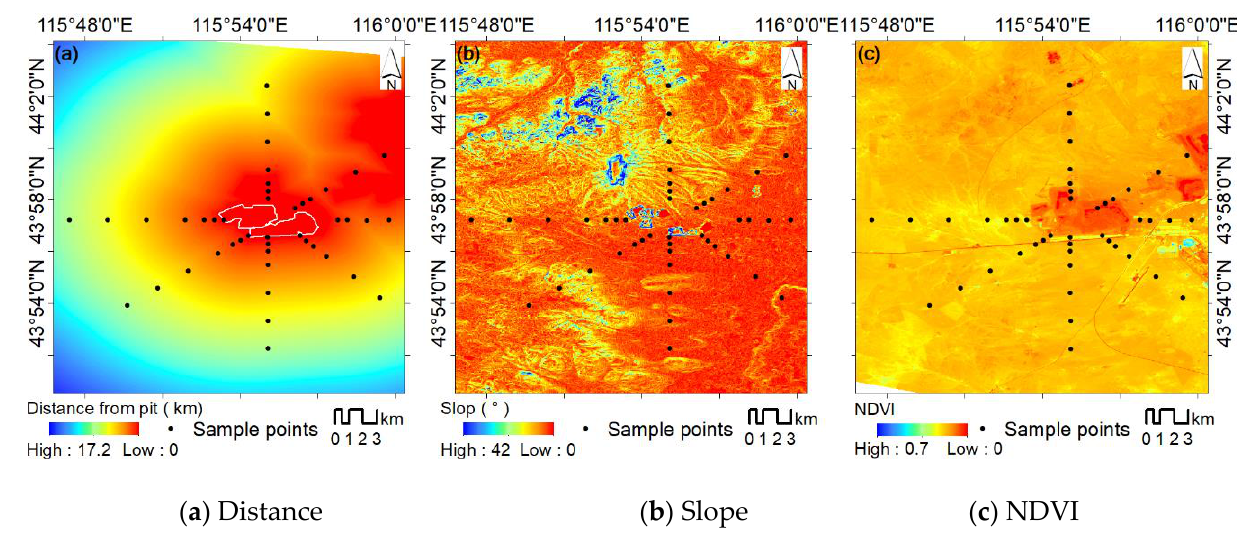
Figure 6. Distance ( a ), slope ( b ), and NDVI ( c ) from the mine in the study area. Table 4. Linear regression results of heavy metal elements in surface soil of mining area with pit distance and NDVI ( n = 44). Heavy Metals